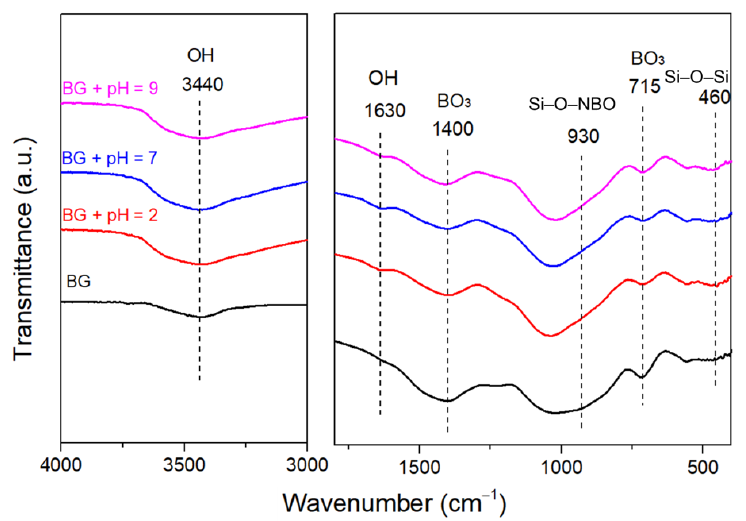
Figure 5. FTIR spectra of the glass samples immersed in Tris buffers with different initial pH for 1 day.